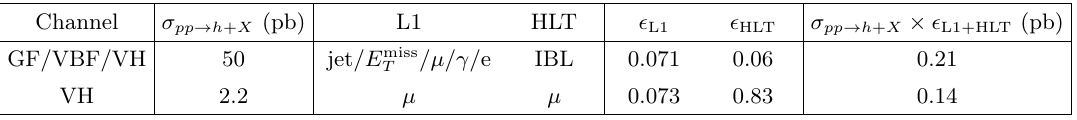
Table 4. Comparison of IBL trigger path with the associated muon trigger path, assuming the X max variable with a level of background rejection of 10 (cid:0) 3